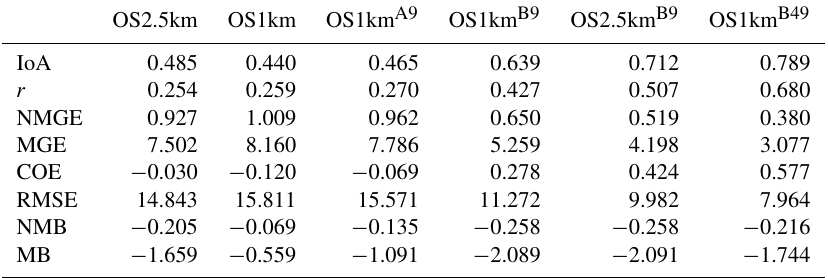
Table B3. Surface NO x observations to model comparison, daytime (09:00–18:00LT) (ppbv, 1252 model–observation pairs).